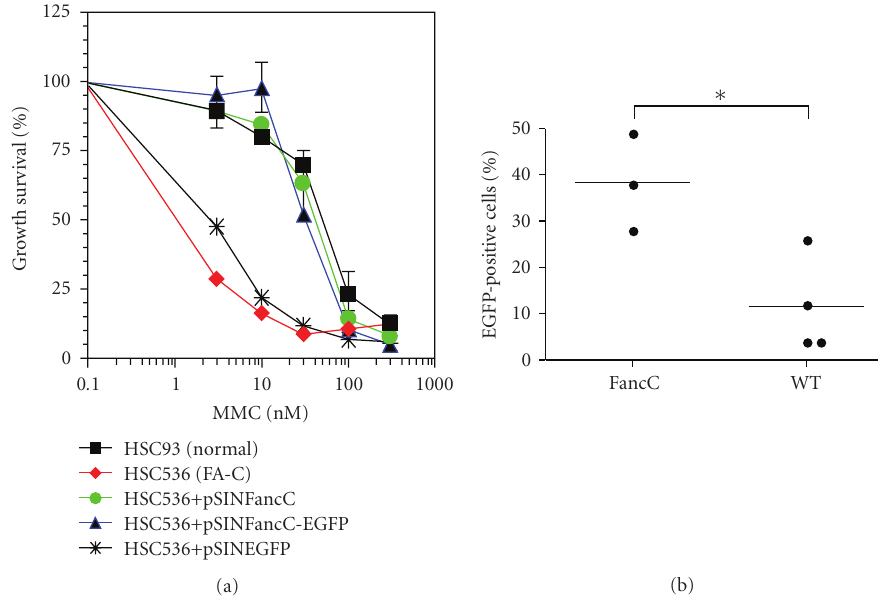
Figure 1: Corrective ability of the FancC -EGFP transgene. (a) FA group C mutant cells (HSC536) were transduced with either pSINFancC and pSINFancC-EGFP or pSINEGFP recombinant lentiviral particles. Growth survival of transduced cells as compared to normal cells (HSC93) was established with various concentrations of mitomycin C (MMC). Each point represents the mean ± SEM of three separate experiments. Absence of SEM bars represents values too low to appear in the graph. (b) EGFP transgene expression in bone marrow cells of intrafemorally injected wild type and FancC − / − mice five months following IF injections. Each dot represents the EGFP expression of an individual IF-injected mouse. Horizontal line: mean value. ∗ P < .